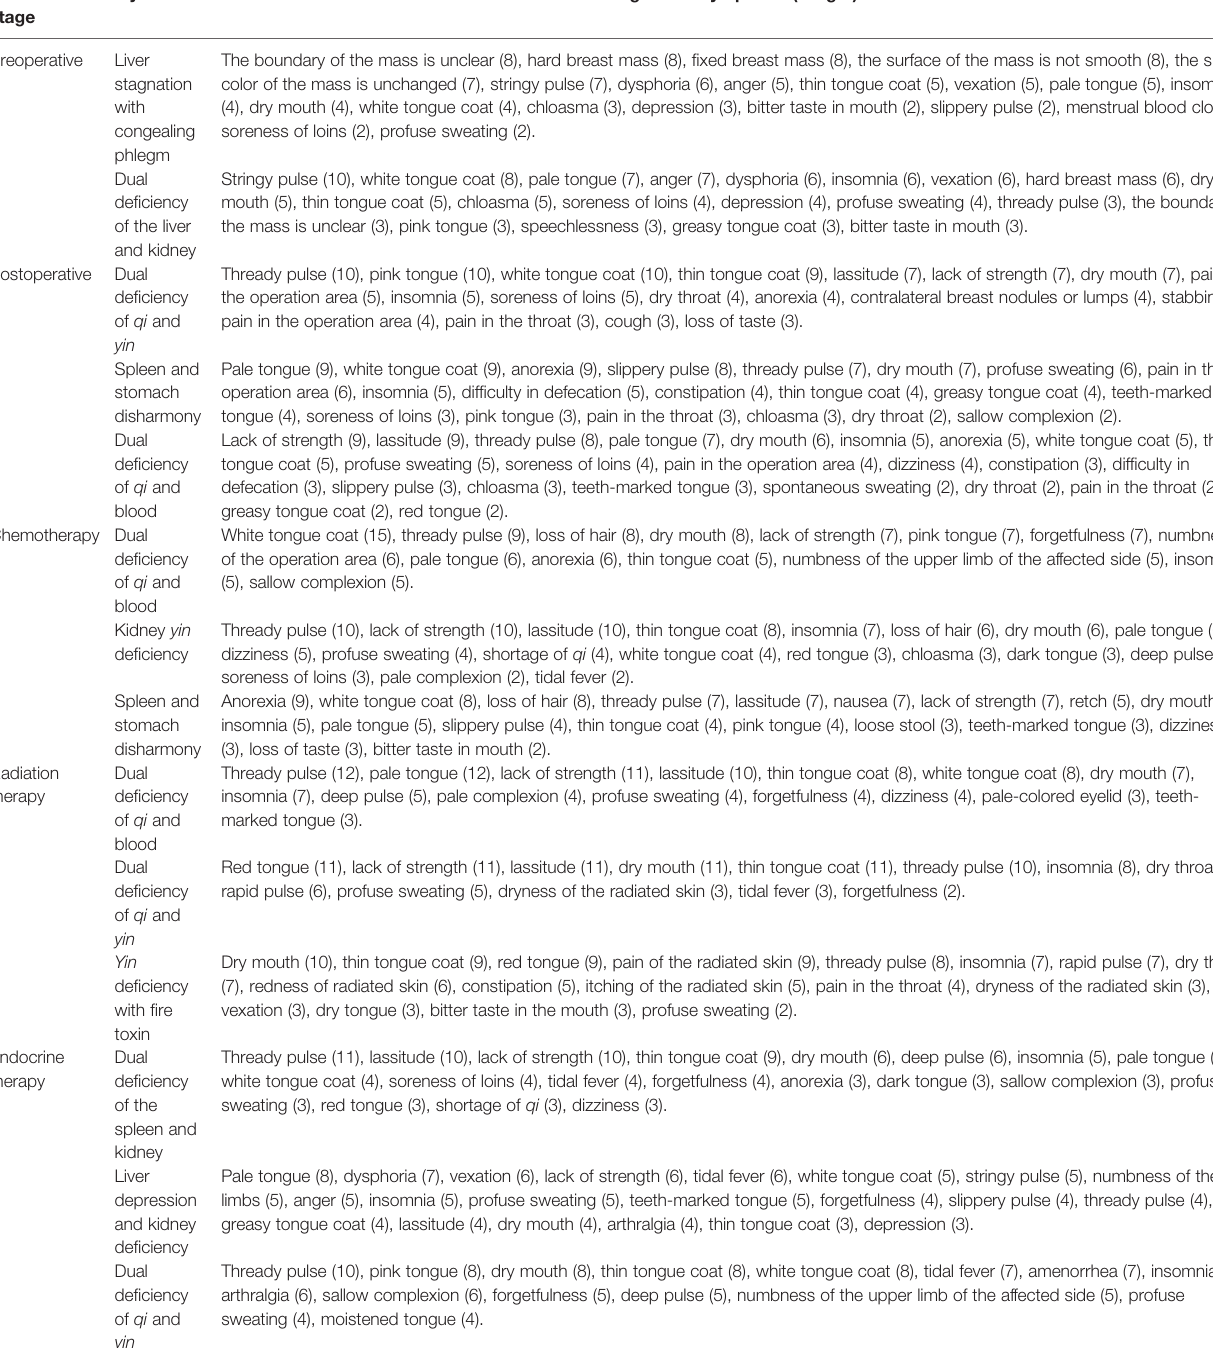
indicated dual de fi ciency of qi and blood. The symptom soreness of loins was common to all three clusters. In the postoperative treatment stage, soreness of the loins is less likely to indicate kidney de fi ciency, and more likely to be the consequence of the requirement to lie down for a prolonged time after surgery.